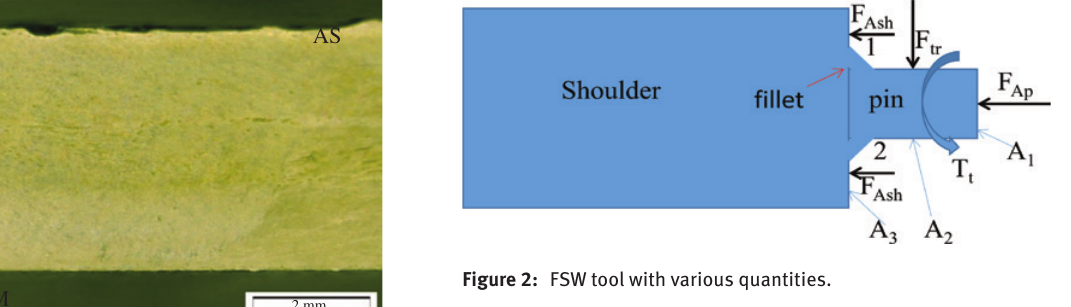
340 RPM Figure 1: Macro image of Mg alloy plate welded cross section sample at 340